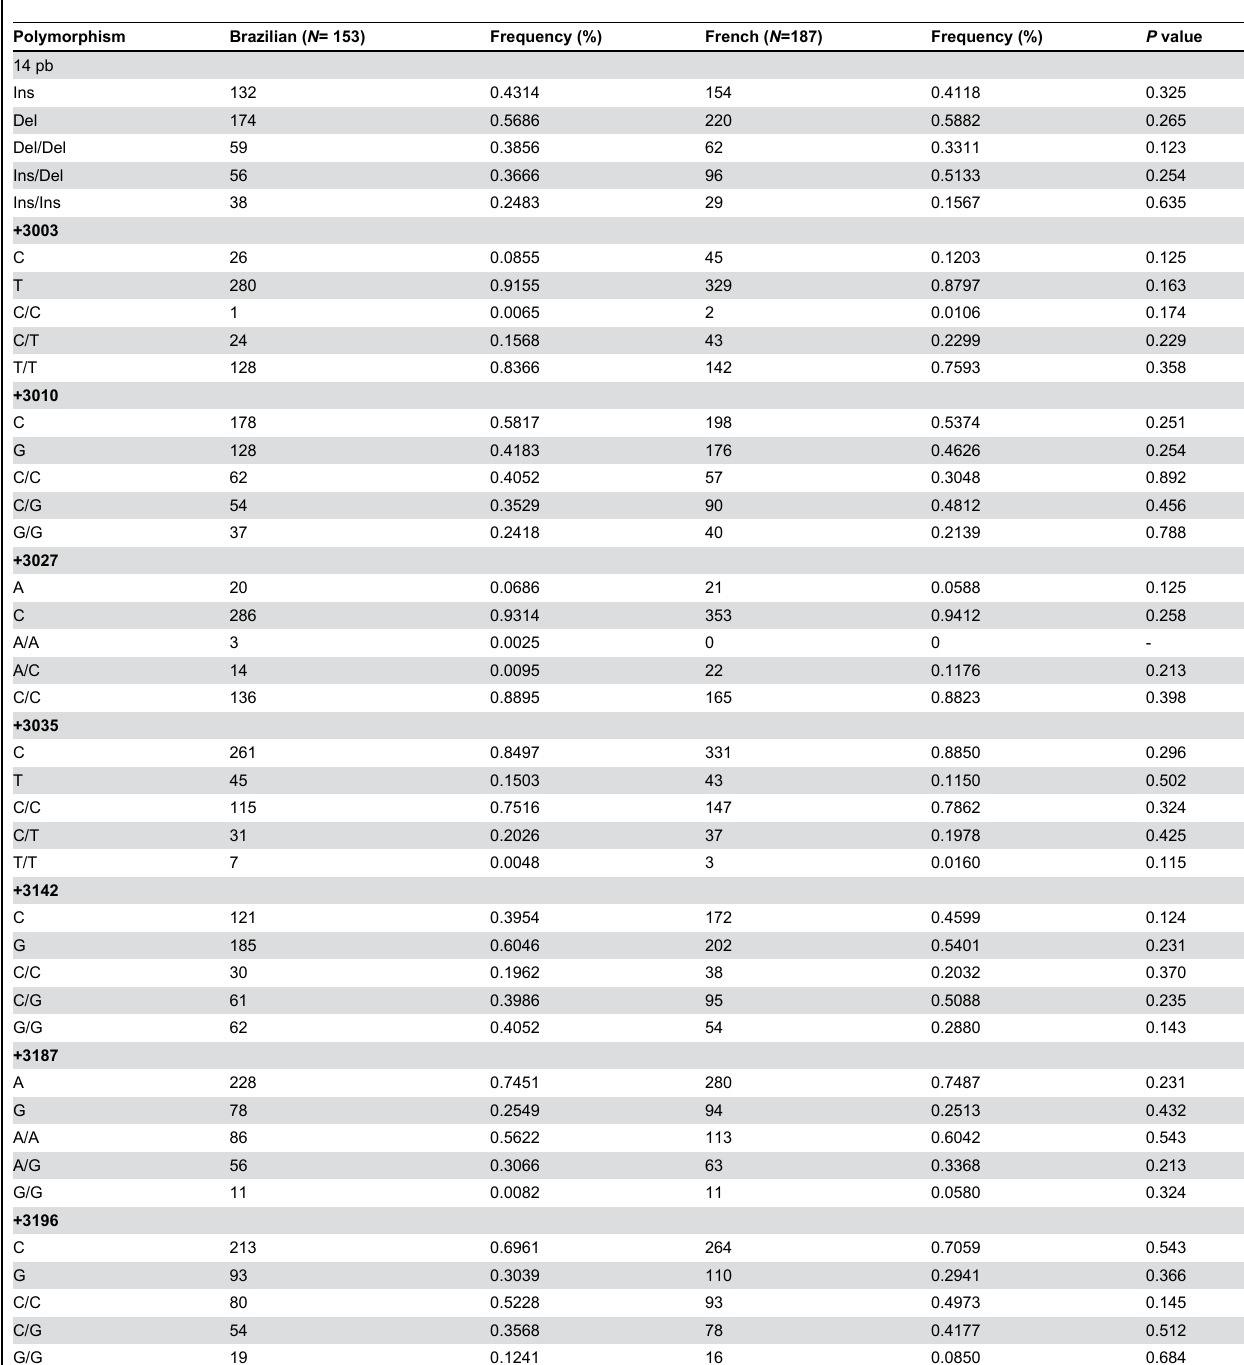
Table 1. Allele and genotype (14 bp Ins/Del, 3003C/T, 3010C/G, 3027A/C, 3035C/T, 3142C/G, 3187A/G, 3196C/G) frequencies observed at HLA-G 3’UTR polymorphic sites in Brazilian and French